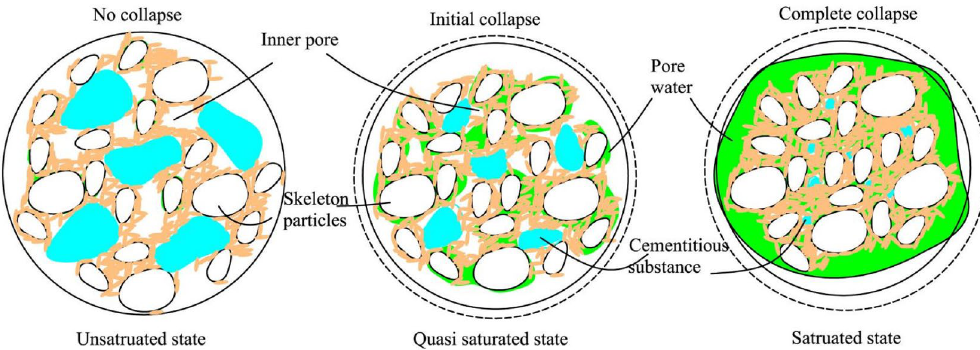
Figure 1. Collapsibility principle of natural loess form the perspective of